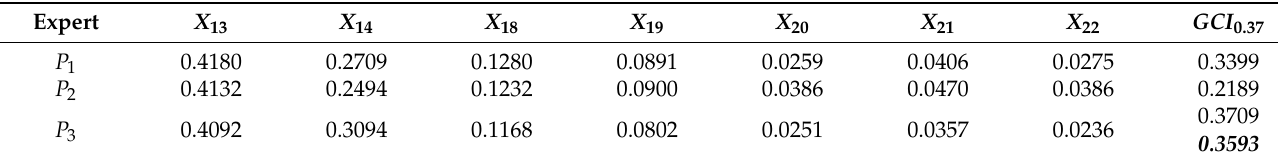
Table 10. Individual weighting results for Node 2.